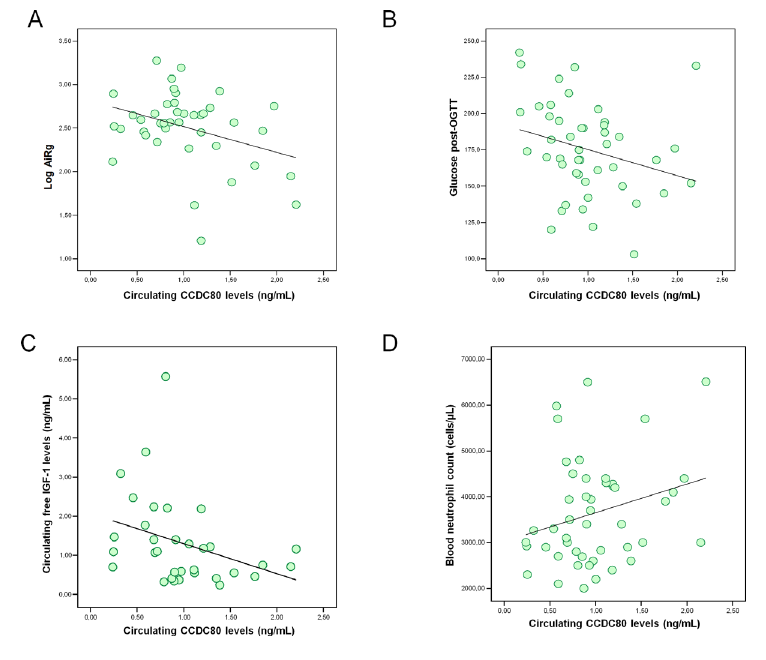
Figure 3. Serum CCDC80 protein levels in a cohort with different degrees of obesity in association with insulin secretion and inflammation parameters. Bivariate correlation analysis showing association of CCDC80 levels with (A) acute insulin response to glucose (AIRg values, which were logarithmically transformed to normalize values), r = –0.35, P = 0.02; (B) with serum glucose levels 30 min post-OGTT, r = –0.34, P = 0.02; (C) circulating IGF1 levels, r = –0.43, P = 0.01; and (D) blood neutrophil count, r = 0.26, P = 0.07.